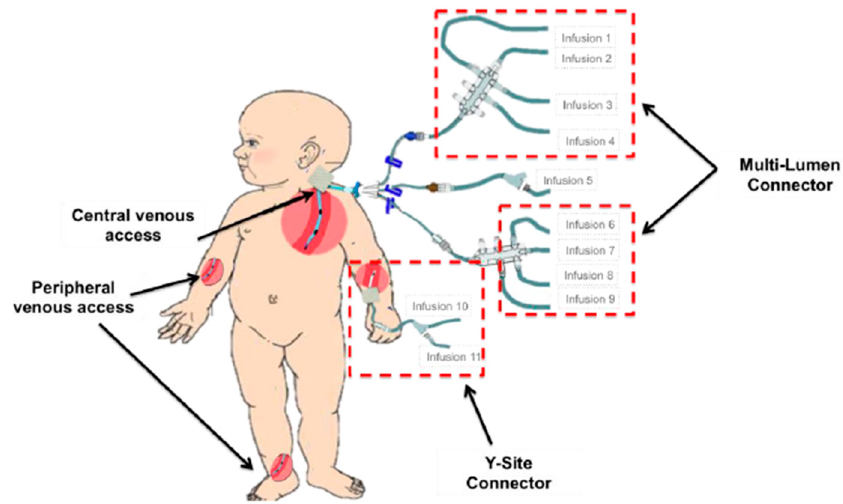
Figure 4. Example of venous access and multiple drug administration devices.